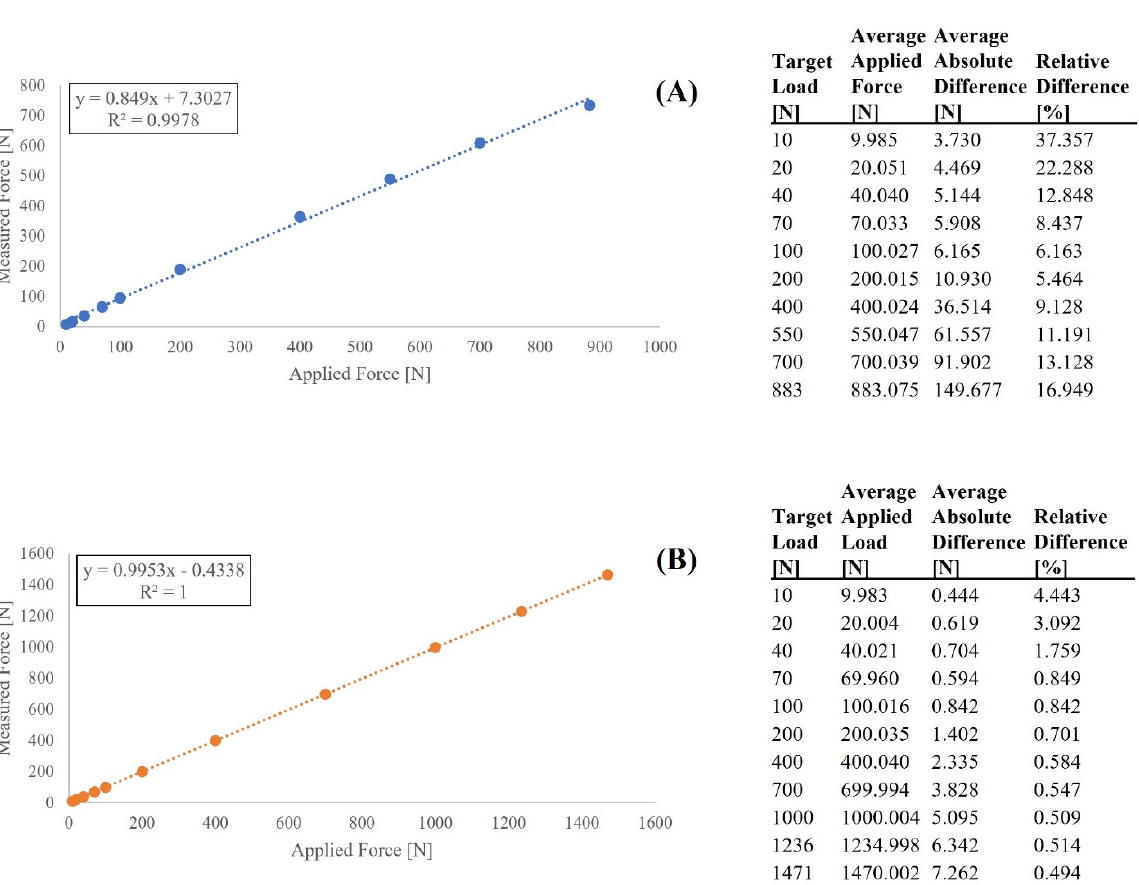
Figure 4. Relation between the force measured by each device and the force applied by gold standard (Instron) for the stepped loadings test. ( A ) The ActivBody Activ5 was tested to 10 different loads over the entire loading range; ( B ) The Tindeq Progressor was tested at 11 different loads. Reported data at each force level correspond to 5 s of measurement when force plateaued at each test load. For both the absolute and relative difference columns, values denote applied force minus measured force. The best-fitting line is also displayed for reference.